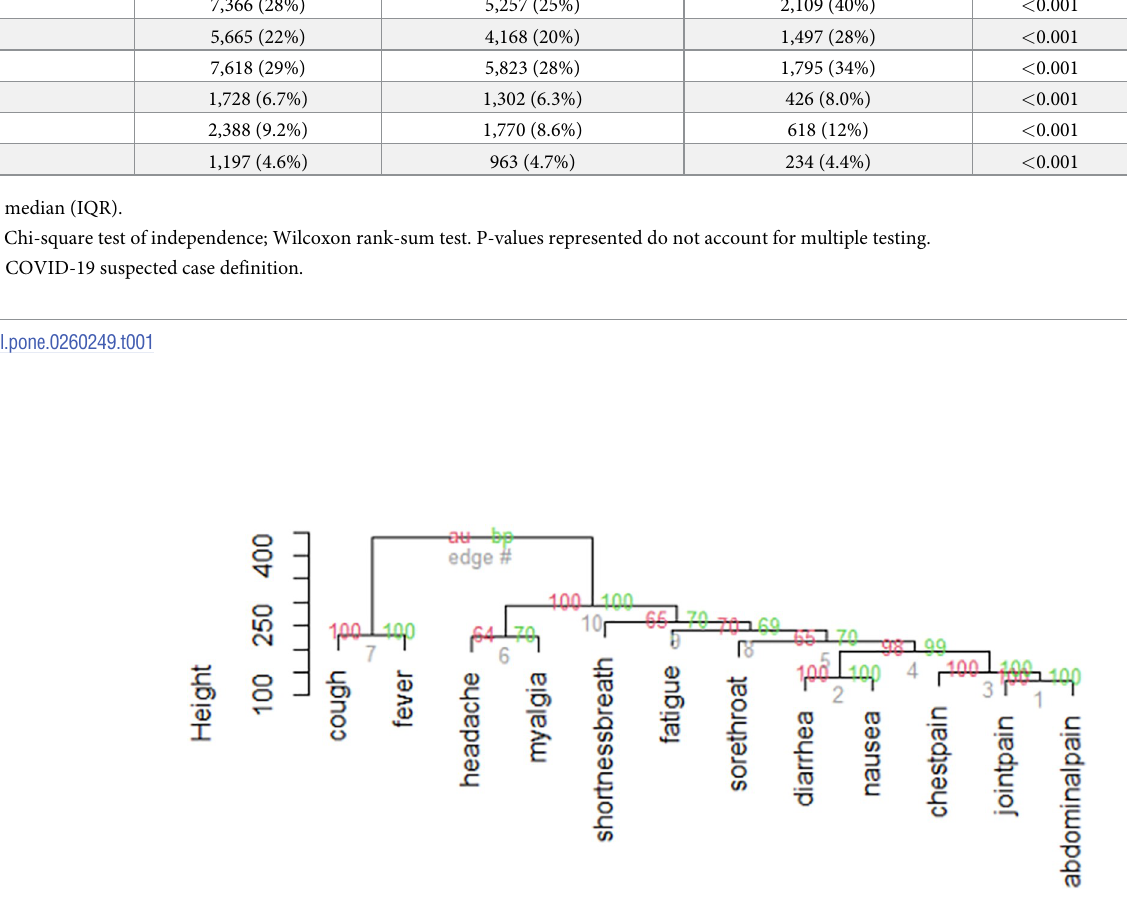
Fig 1. Symptoms cluster dendrogram of COVID-19 patients (n = 5,298). AU: Approximately unbiased p-value; BP: Bootstrap